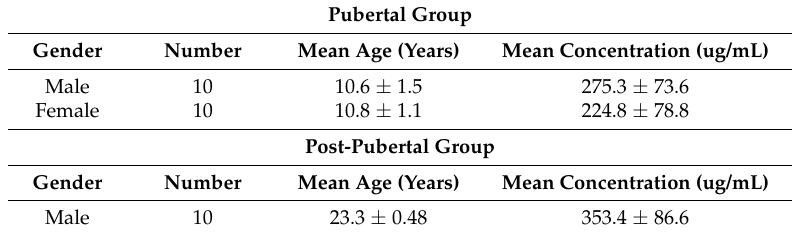
Table 1. Detailed information of studied subjects.